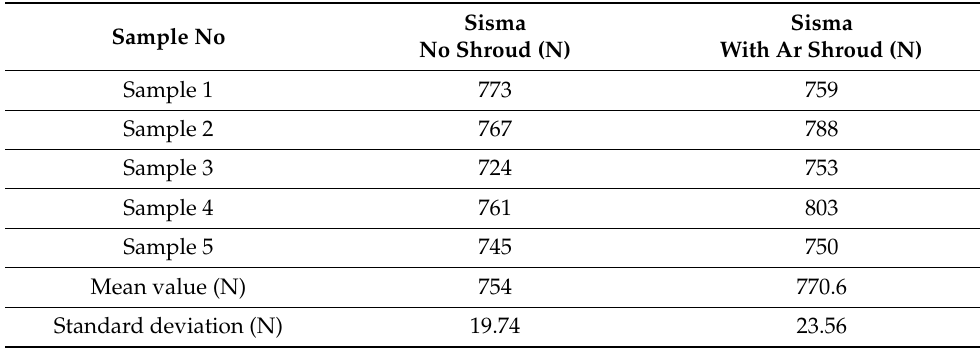
Table 4. Tensile shear test results of the fabricated micro-joints.